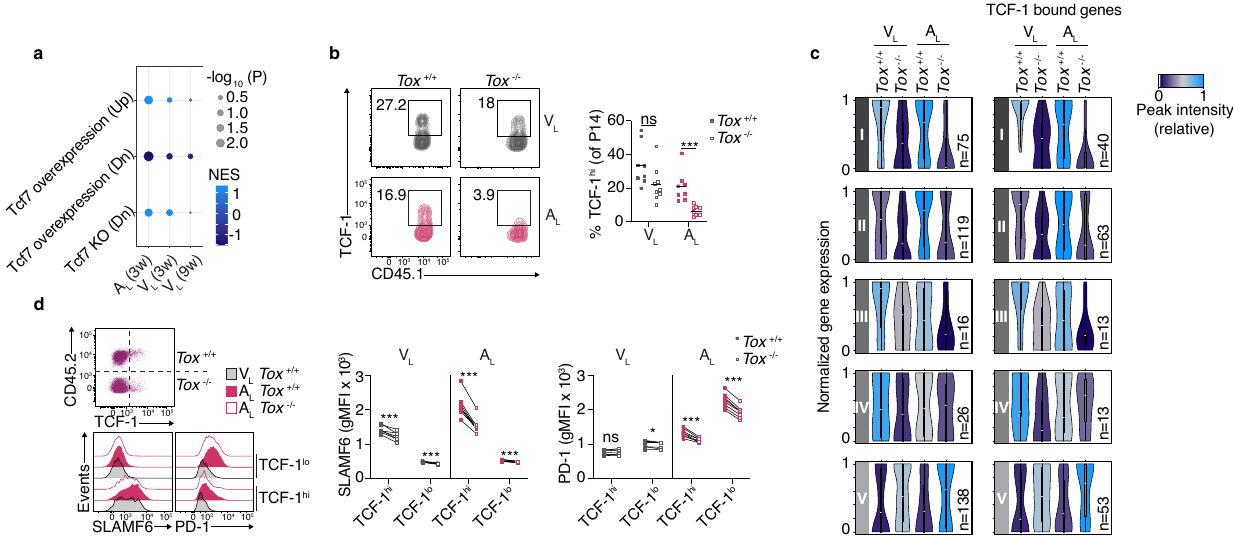
Fig. 6 TOX predominantly preserves the pool of self-reactive TCF-1 hi CD8 + T cells. 10 4 naive Tox + / + or Tox − / − P14 cells were adoptively transferred into WT and MOG-GP mice. One day later (day 0), mice were challenged i.c. with 10 4 PFU rLCMV-GP33 and brain in fi ltrating P14 cells were FACS sorted for RNA-seq ( a and c ), ATAC-seq ( c ) and fl ow cytometric analysis ( b ) at indicated days post infection. a GSEA of TCF-1 speci fi c signatures 27 in a ranked list of genes differentially expressed by Tox + / + vs. Tox − / − A L and V L at indicated time points. NES: normalized enrichment score. b Frequency of